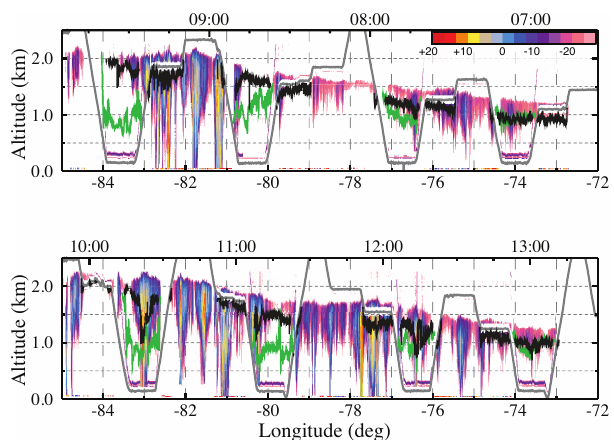
Fig. 1. Time-height sections of RF04 WCR 94GHz cloud radar reflectivity (dBZ scale shown in the upper right of the top panel). Top panel: outbound flight, bottom panel: return flight. Lidar cloud base during subcloud legs is shown in black, LCL from in-situ mea- surements is shown in green, and flight path is shown in